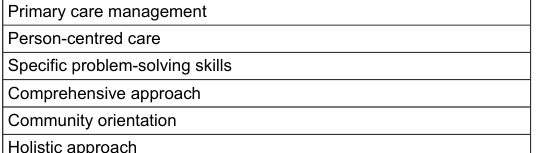
Figure 1: Methodology